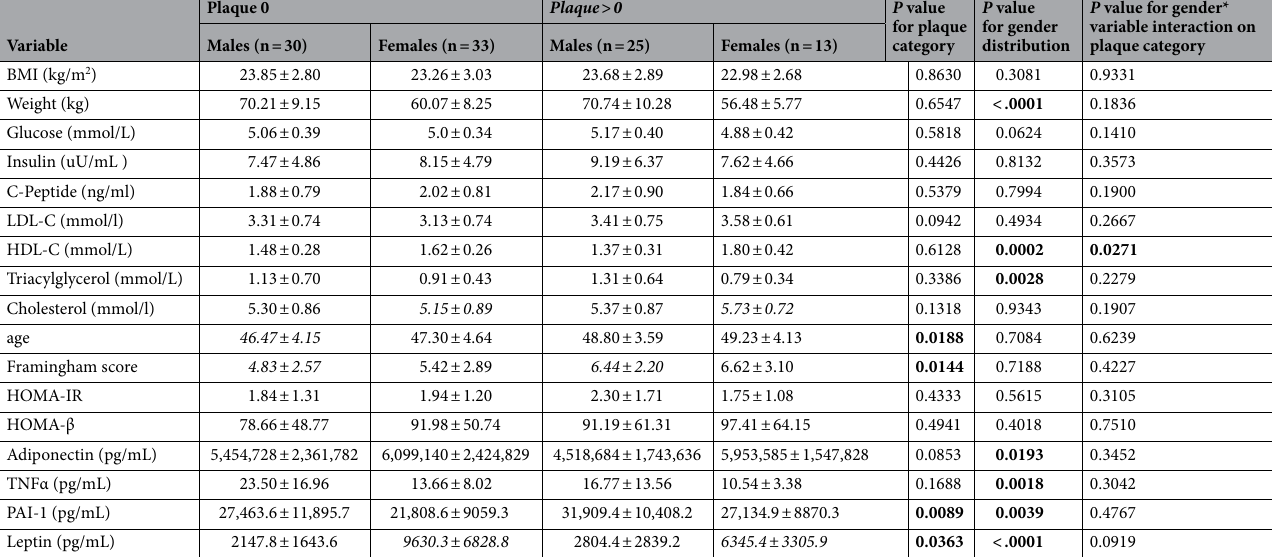
Table 3. Demographic and clinical characteristics at baseline (fasting state) for atherosclerotic plaque versus no atherosclerotic plaque groups stratified by gender. In italic are significant differences between plaque category within gender subgroups (* P < 0.05). Significant values are in